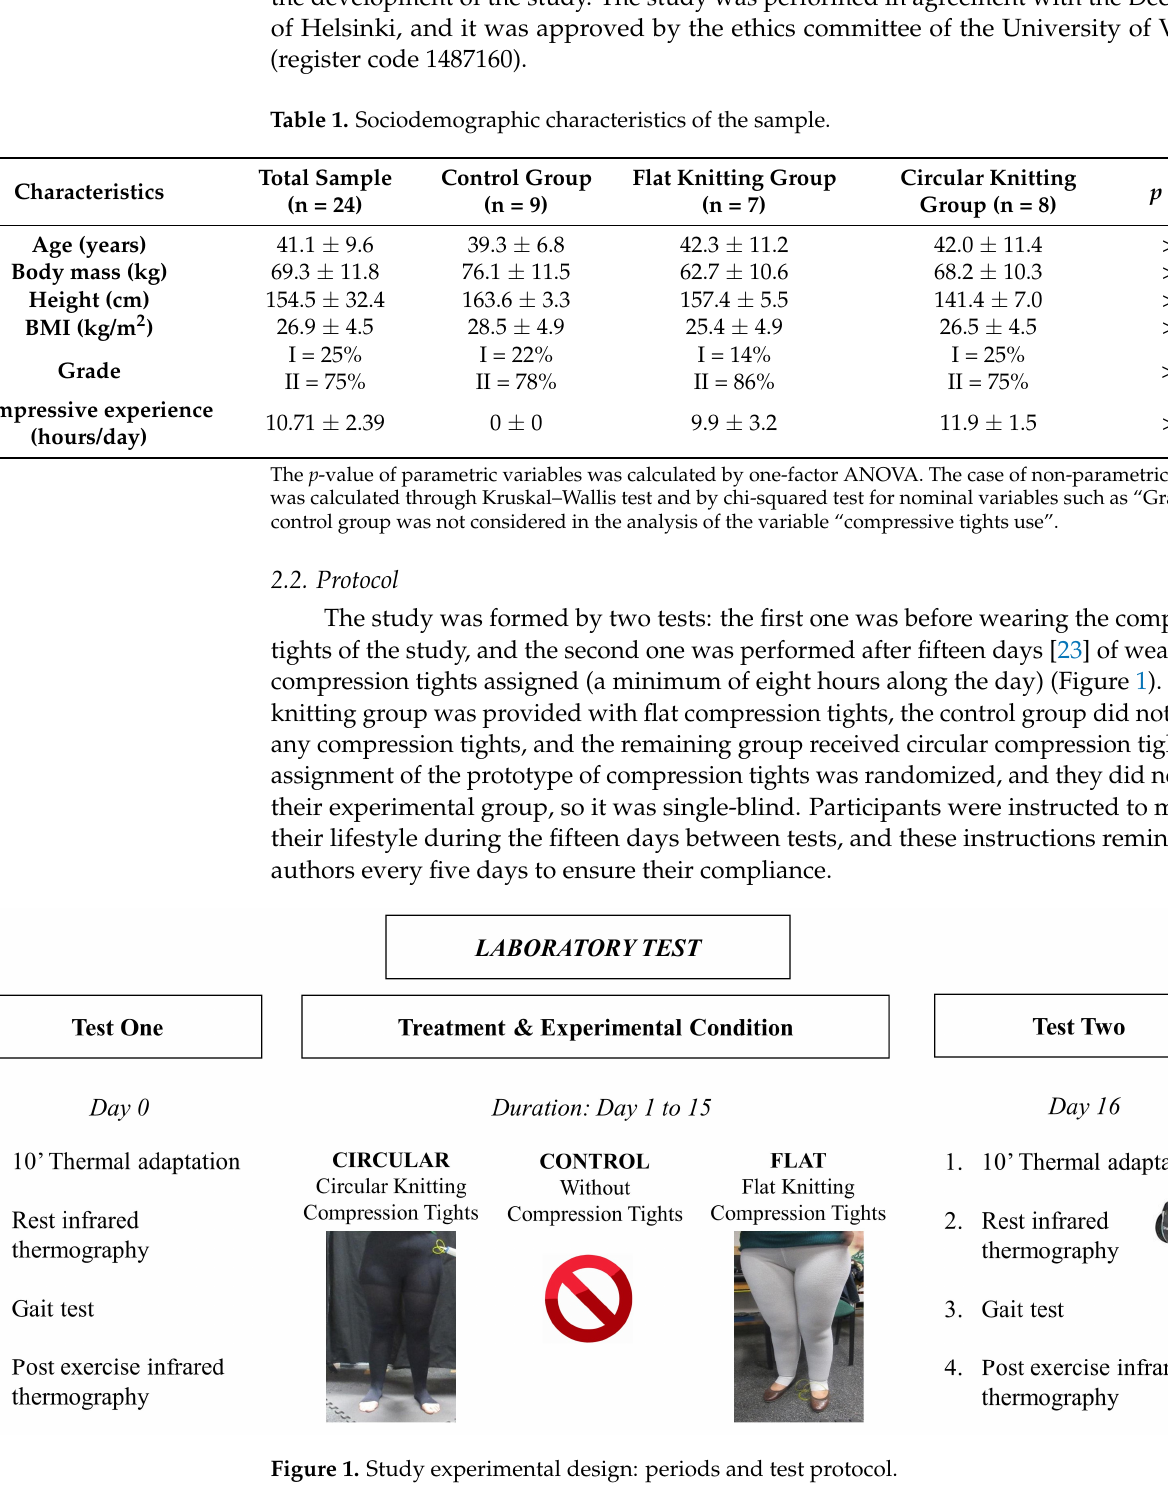
Figure 2. Gait test on walkway delimited by photo cellules. 2.3. Compression Tights Two prototypes of compression tights were delivered and tested for the study by Textile Technology Institute (AITEX); in this sense, the contours and lengths of the leg of each participant were measured by the same researcher according to the RAL-GZ 387 standard [27] in order assign the appropriate size for them. Flat knitting compression tights are formed from the following materials: 65% viscose, 26% polyamide, and 9% elas- tane. Circular knitting compression tights are compounded by 60% polyamide and 40% elastane. The pressure generated by the garments was measured by AITEX using a certi- fied system, a Salzmann MST MK IV (MST MK V, Swisslastic Ag St, Gallen, Swiss). The Salzmann device consists of a thin plastic sleeve (0.04 m wide, 0.0005 m thick) with four to six paired electrical contact points (depending on the length of the probe) [28]. There- fore, the garments were located in standard wooden legs according to RAL-GZ 387/1 measures that simulate the leg where the sensors of this system measure the pressure [28]. The pressure is measured in mmHg. Figure 3 shows the values of compression (mmHg) generated by the compression tights assessed in the different locations. In relation to the thermal properties of the compression tights, water vapor resistance and thermal re- sistance were measured according to the normative ISO 11092:2014. Textiles, physiologi- cal effects, and measurement of thermal and water vapor resistance were tested under steady-state conditions (sweating-guarded hotplate test). The thermal resistance was measured in m 2 ·K/W, and the water vapor resistance was measured in m 2 ·Pa/W. The ther- mal resistance of flat knitting compression tights and circular knitting compression tights